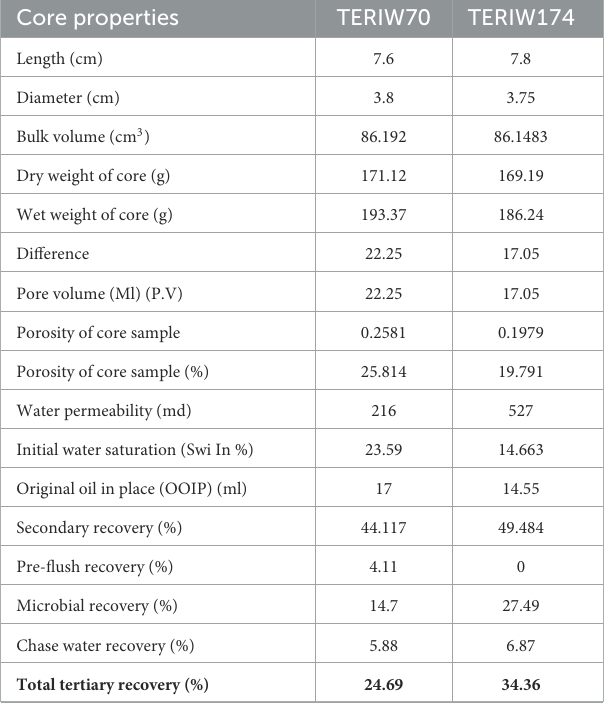
TABLE 3 Properties of the core sample and recovery data for consortia TERIW70 and